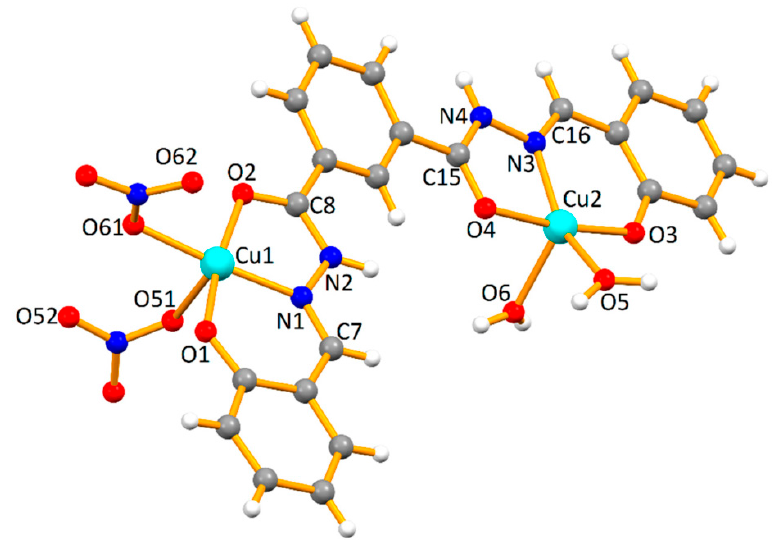
Figure 5. Complex 7 Adapted from Ref. [67], Copyright (2018), Molecules (MDPI), Open Access.